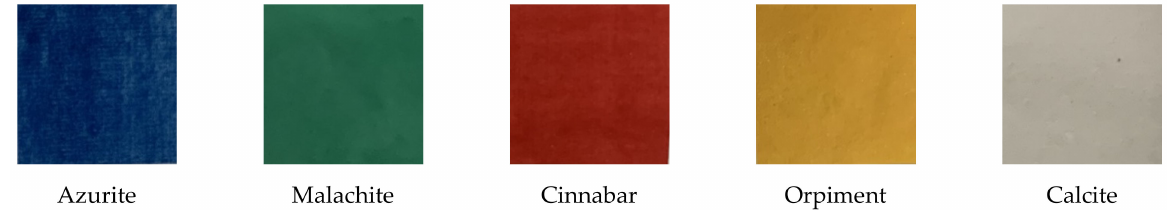
Figure 1. The sample blocks of pure pigments.